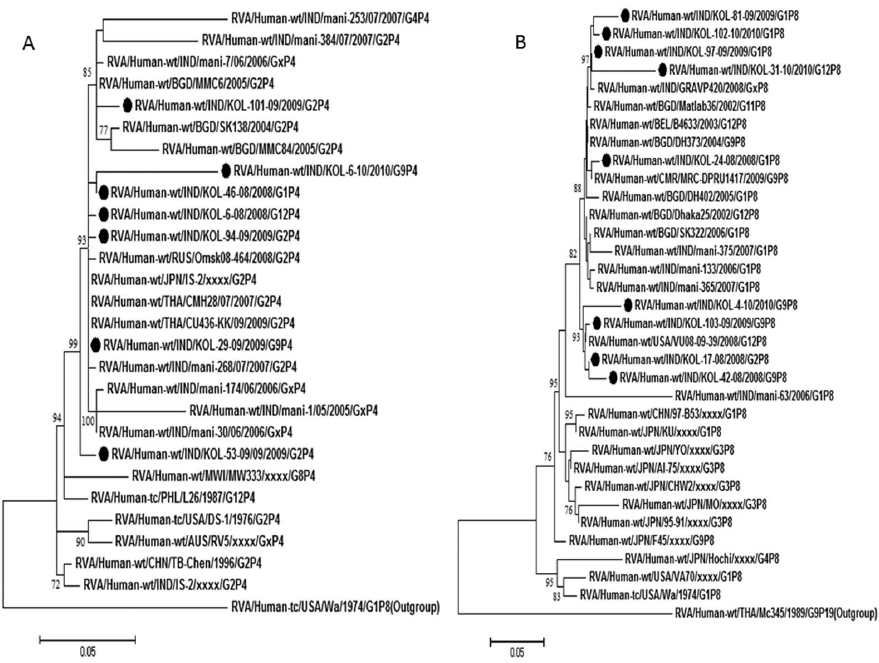
Figure 6. A and B. Phylogenetic trees of the P [4] and P [8] strains of Kolkata. Phylogenetic trees constructed from the nucleotide sequences of VP4 genes of A. P[4]; and B. P[8] strains of Kolkata, isolated during January 2008 through December 2010, with other representative P[4] and P[8] strains respectively. Scale bar, 0.05 substitutions per nucleotide. Bootstrap values less than 70% are not shown.